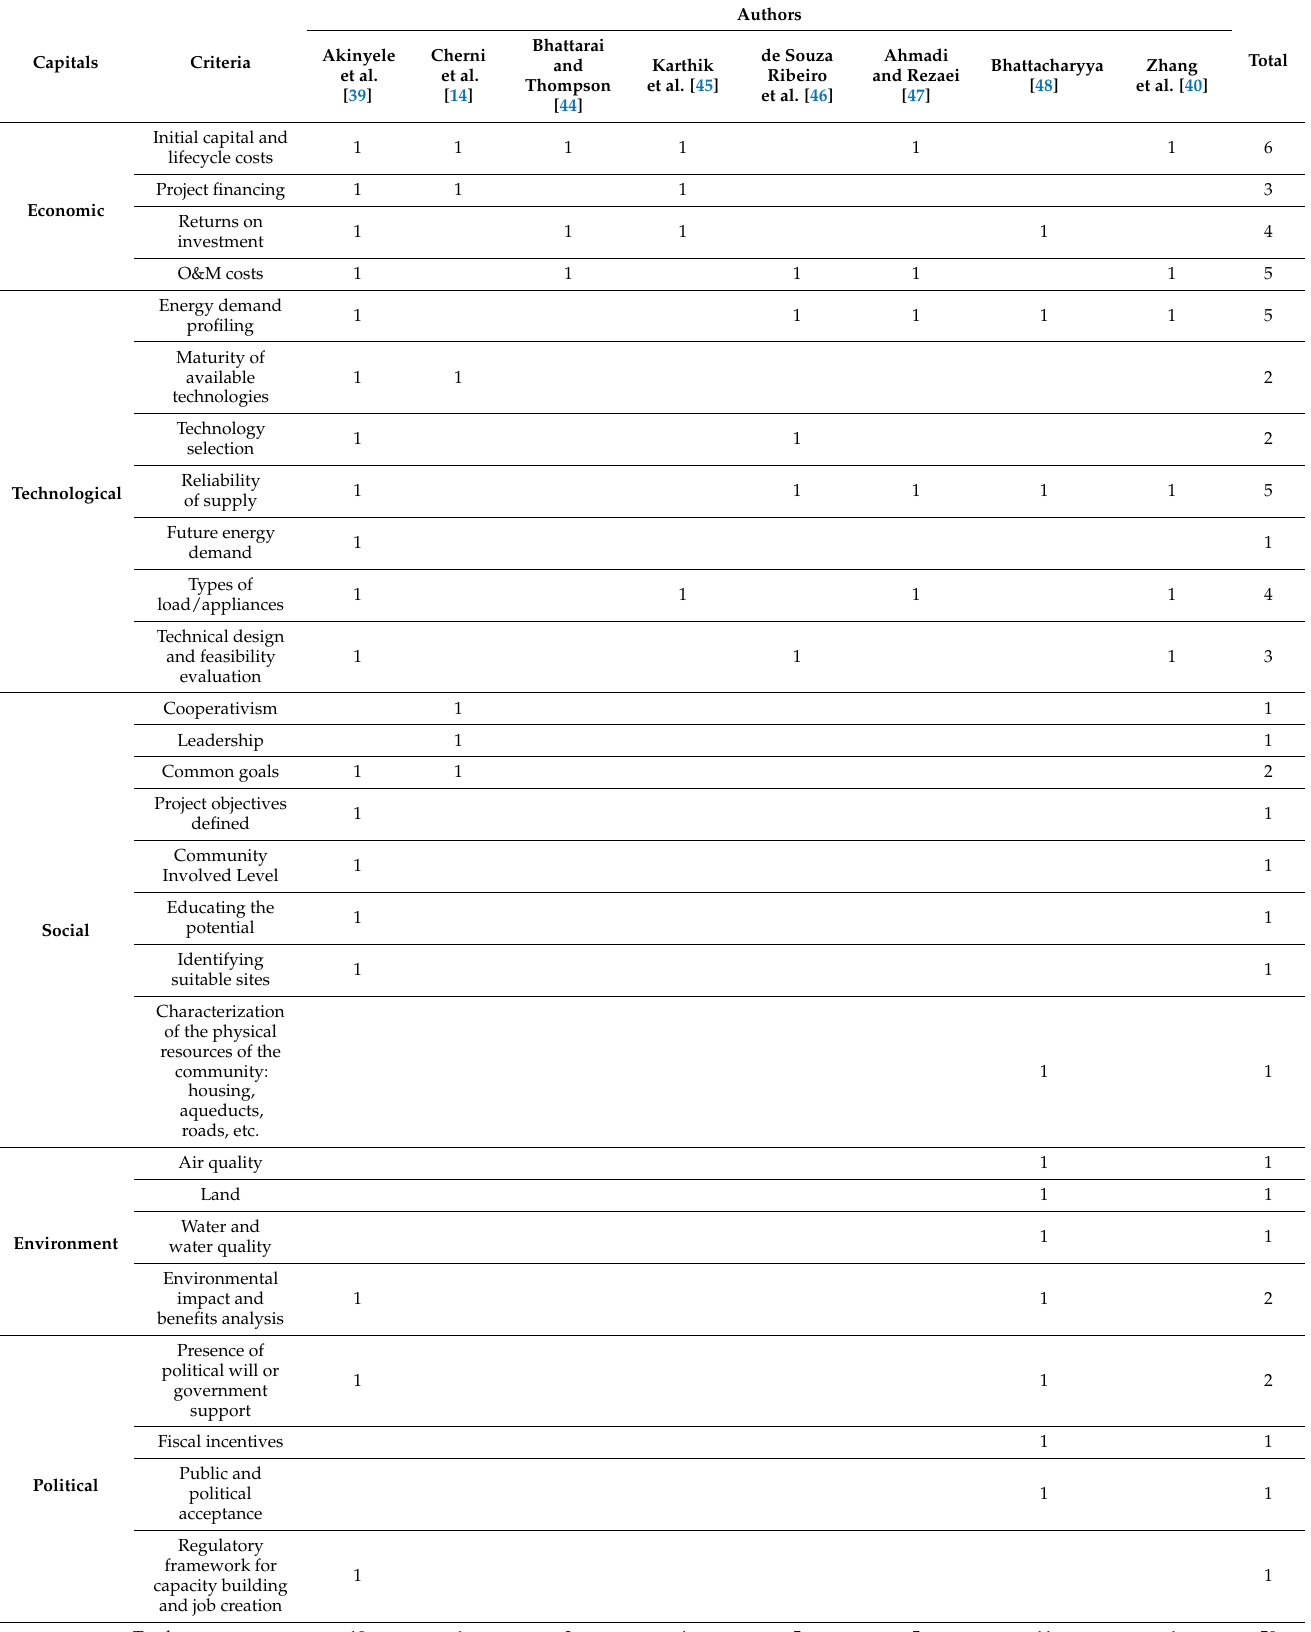
Table 3. Criteria and factors of endogenous models for decision-making